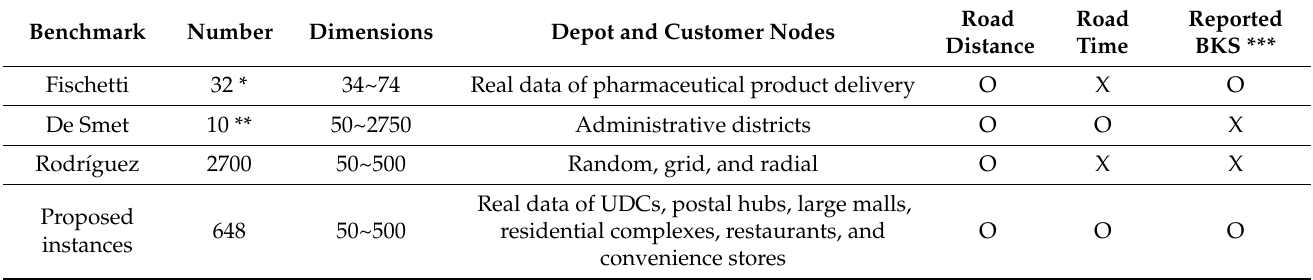
Table 4. Comparison of ACVRP benchmark